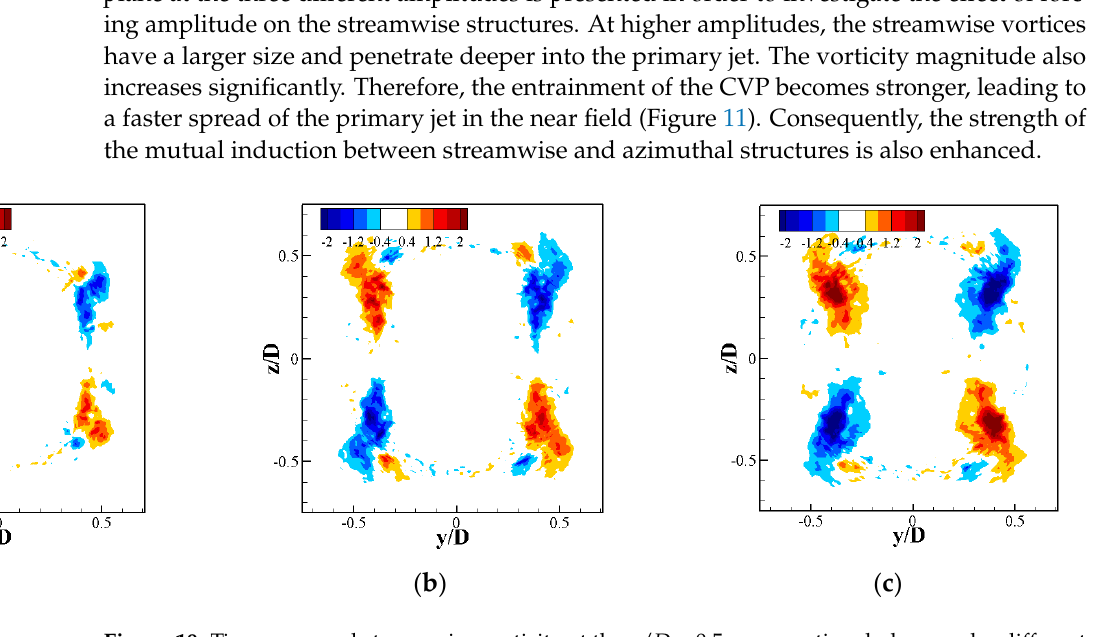
Figure 19. Time-averaged streamwise vorticity at the x / D = 0.5 cross-sectional plane under different amplitudes, normalized by U j / D . ( a ) MFR = 0.67%, ( b ) MFR = 1%, ( c ) MFR = 1.5%.